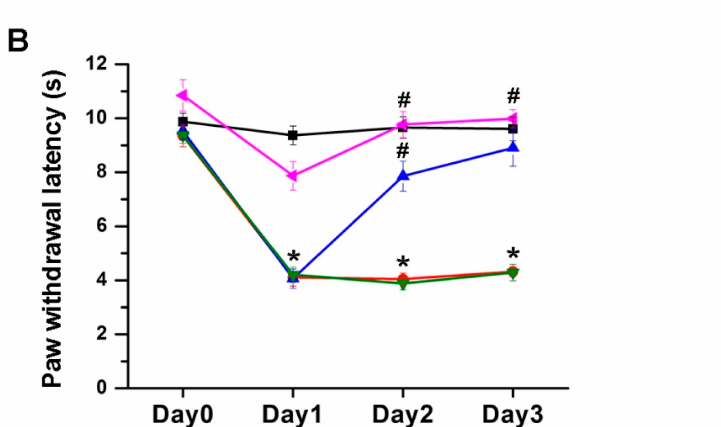
Figure 1. Comparative graph of paw withdrawal threshold and latency of the Complete Freund’s Adjuvant (CFA)-induced inflammatory pain subjects after Electroacupuncture (EA) treatment and transient receptor vanilloid member 1 (TRPV1) gene deletion. n = 8 for five groups: control, CFA, CFA + EA, CFA + SHAM, and CFA + KO underwent ( A ) mechanical von Frey and ( B ) thermal Hargreaves’ tests. The results demonstrated parallel tendencies between the two tests. The CFA injection significantly increases hyperalgesia in mechanical and thermal sensitivity. The significant reducing threshold and latency were increased using 2 Hz EA at ST36 and TRPV1 gene deletion. * p < 0.05 means when compared with the baseline of control group. # p < 0.05 means when compared with the CFA and CFA + SHAM